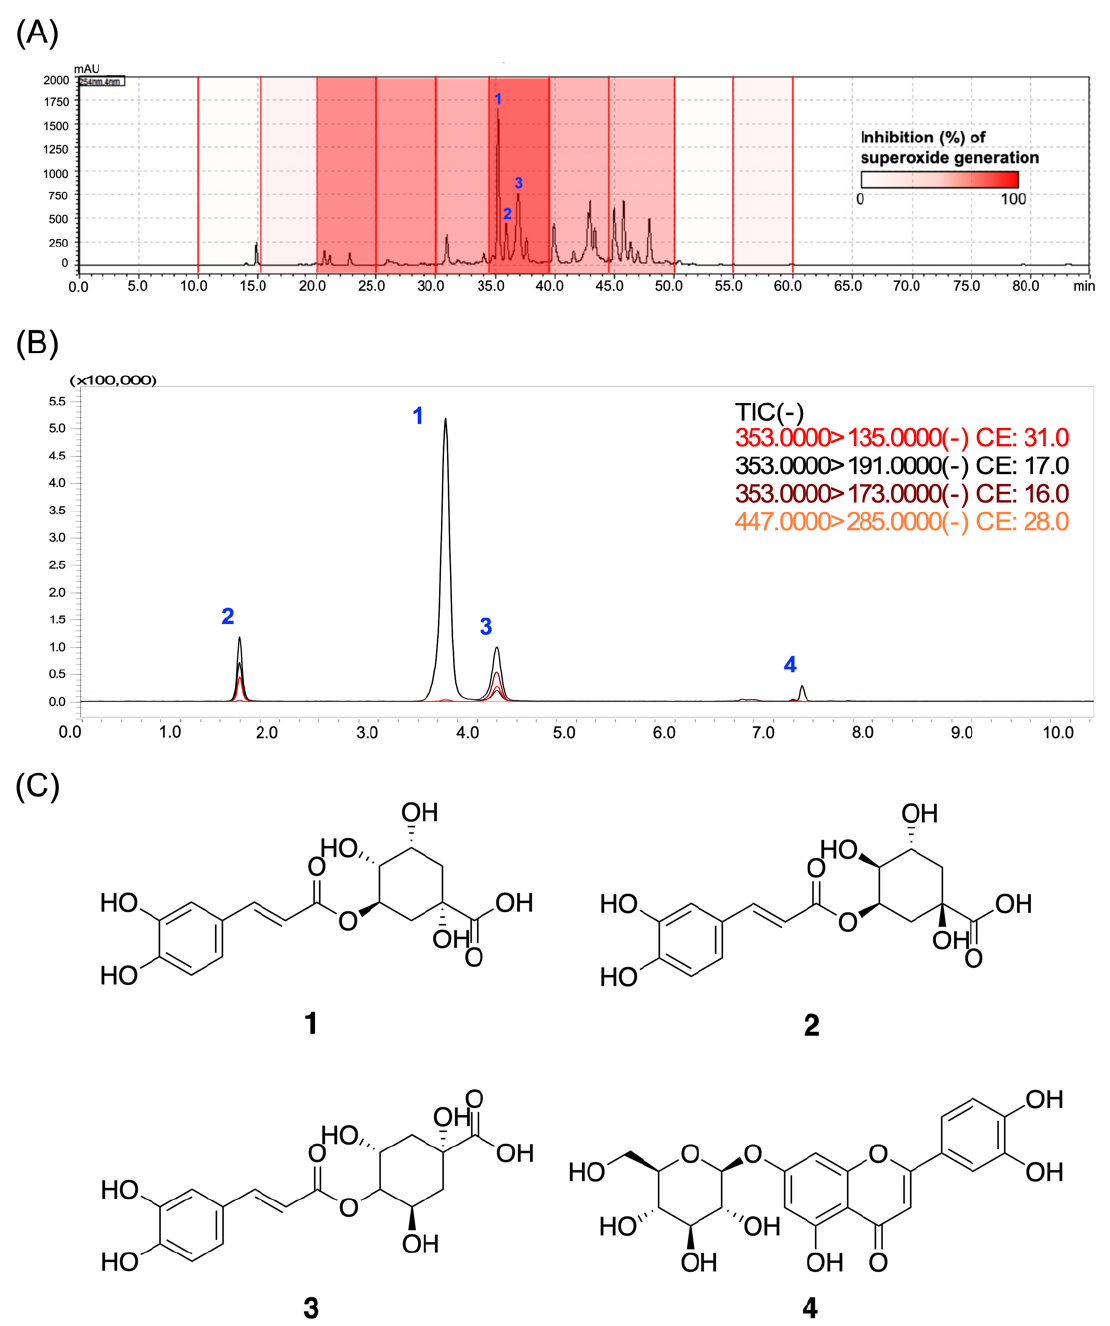
Figure 6. The biological evaluation of the bioactive compounds from LJEE. ( A ) The bioassay-coupled high-performance liquid chromatography (HPLC) profile was performed using the retention time-based fractionation approach, together with the assessments of superoxide anion inhibitions (10 µ g/mL). ( B ) The total ion current (TIC) and product ions chromatogram of the LJEE compounds from multiple reaction monitoring (MRM) experiments. ( C ) The chemical structures of the identified chlorogenic acid ( 1 ), neochlorogenic acid ( 2 ), cryptochlorogenic acid ( 3 ), and cynaroside ( 4 ) from LJEE.